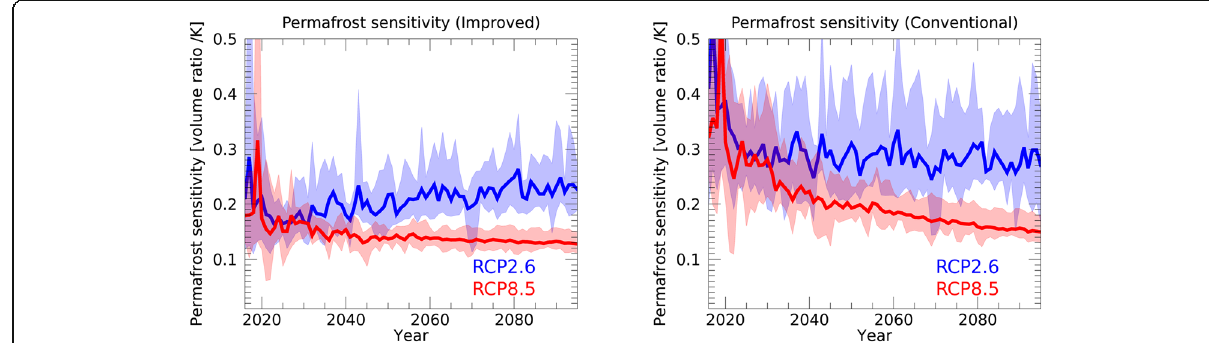
Fig. 9 Time sequence of permafrost sensitivity. The change in permafrost volume divided by the change in global mean surface air temperature [ratio/degree] is shown. The width of the colored bands represents the maximum and minimum values of the simulated results forced by the five GCMs; the average value is represented by the bold lines. The simulations with the improved (left) and conventional (right) schemes under RCP2.6 (blue) and RCP8.5 (red) scenarios are shown. Anomaly of permafrost volume and surface air temperature is calculated with respect to the 1995 – 2014 average.